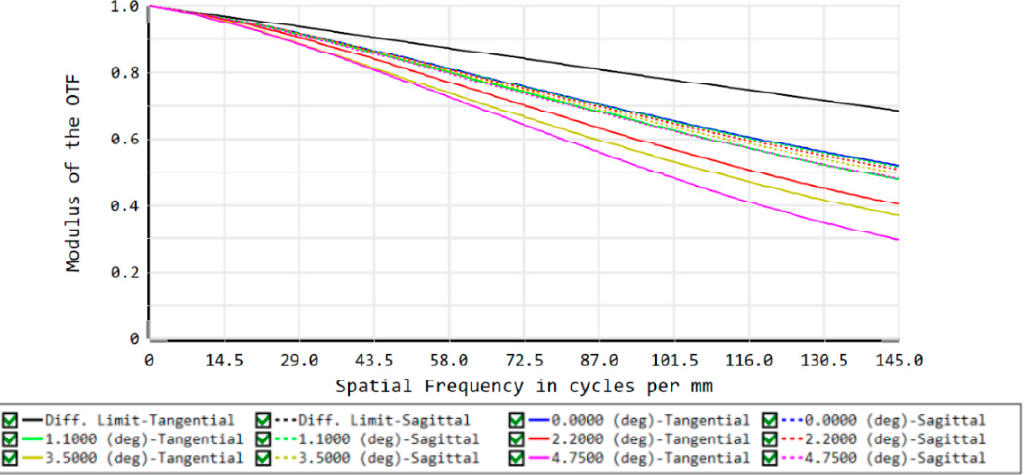
Figure 10. MTF curves of the concentric multi-scale optical system.